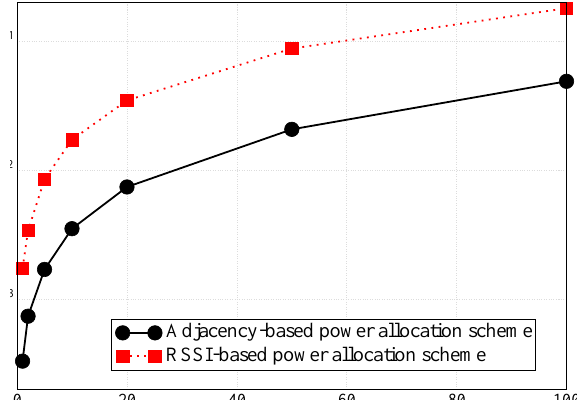
Figure 14. P comparison between the proposed power allocation scheme and the RSSI- er based power allocation strategy presented in [11].